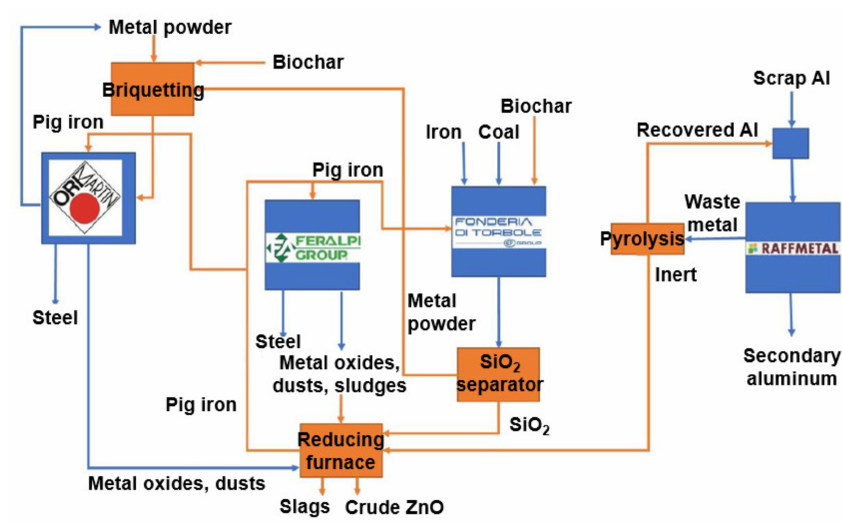
Figure 15. Brescia use case for industrial symbiosis within the CORALIS project